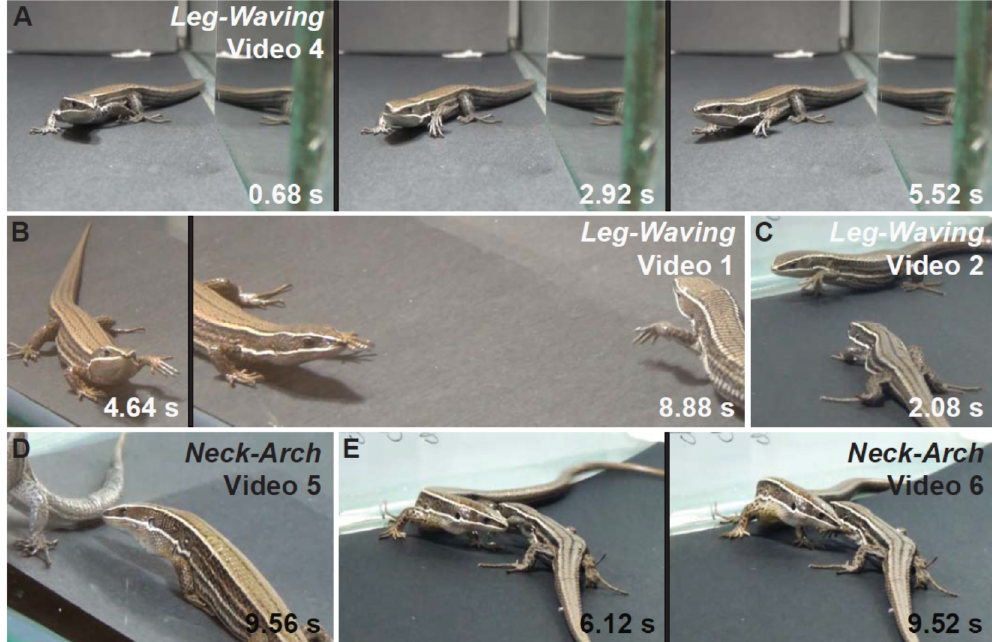
Figure 4. Leg-waving and neck-arch behaviors in P. montium . Still images and series from the Supplementary Videos. The time in the lower corner is in seconds and fractions of seconds (0.00 s). ( A ) Leg-waving in a mirror experiment performed by a Female (Video S4). ( B , C ) Mutual leg-waving performed by two males. ( D , E ) Neck-arch behavior performed by two males. Video S6 is a continuation from video 2.